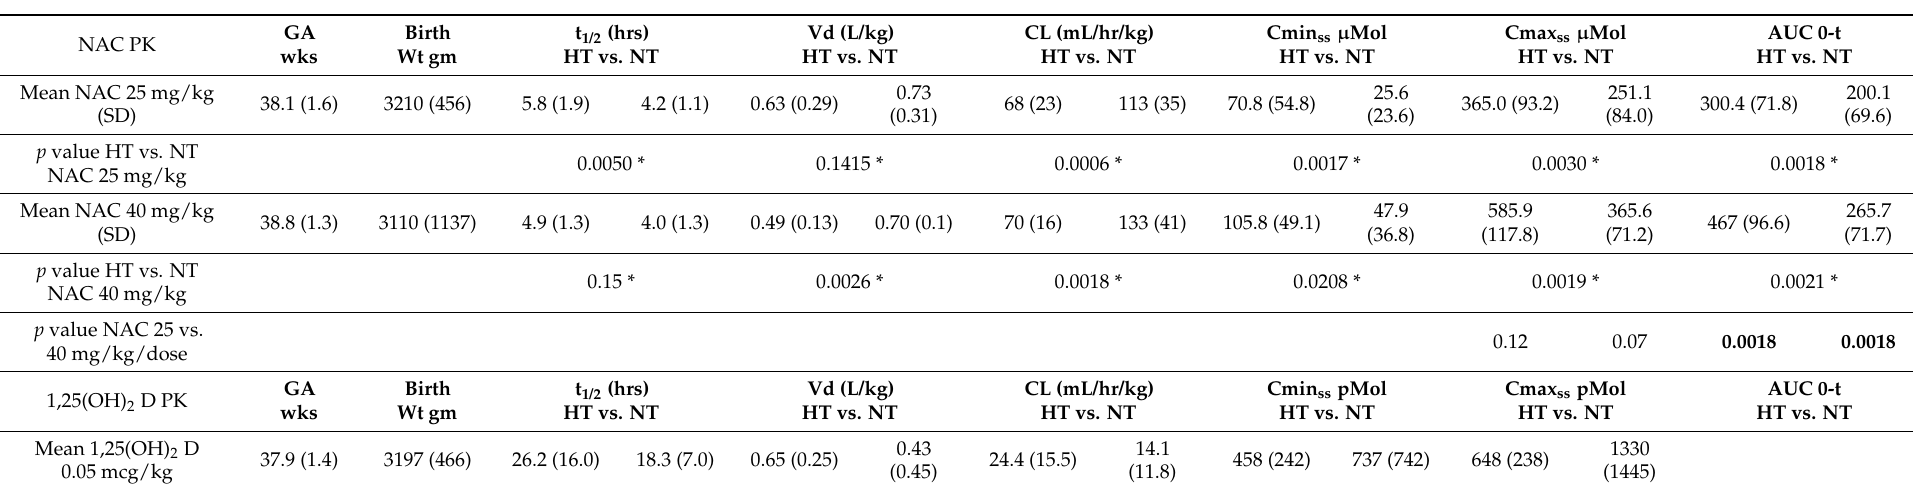
Table 2. NAC and 1,25(OH)2D PK during HT and